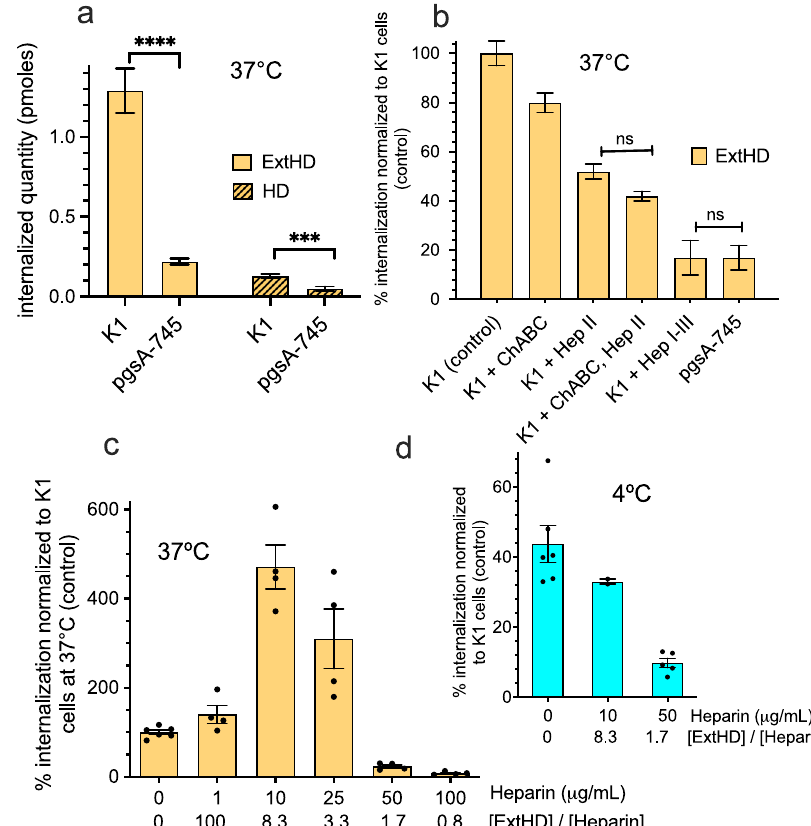
Fig. 2 | Quantitation of ExtHD and HD internalization in cells and impact of GAGs content. a Quantity (pmoles) of internalized ExtHD and HD incubated at 7 µ M with 10 6 CHO-K1 or GAG de fi cient pgsA-745 cells for 1h at 37°C ( n =27 and 18 for CHO-K1 and pgsA-745 cells, respectively). CHO-K1 express similar levels of HS and mono-sulfatedchondroitins 68 ;pgsA-745express10 – 30-foldlowerGAGslevelsthan CHO-K1 28 . b Quantity of internalized ExtHD incubated at 7 µ M with cells for 1h at 37°C ( n =12 – 18). Data were normalized to the quantity of internalized ExtHD in control CHO-K1 cells. CHO-K1 cells were treated with enzymes degrading HS (heparinases I, II, III) or CS (chondroitinase ABC). c , d Quantity of internalized